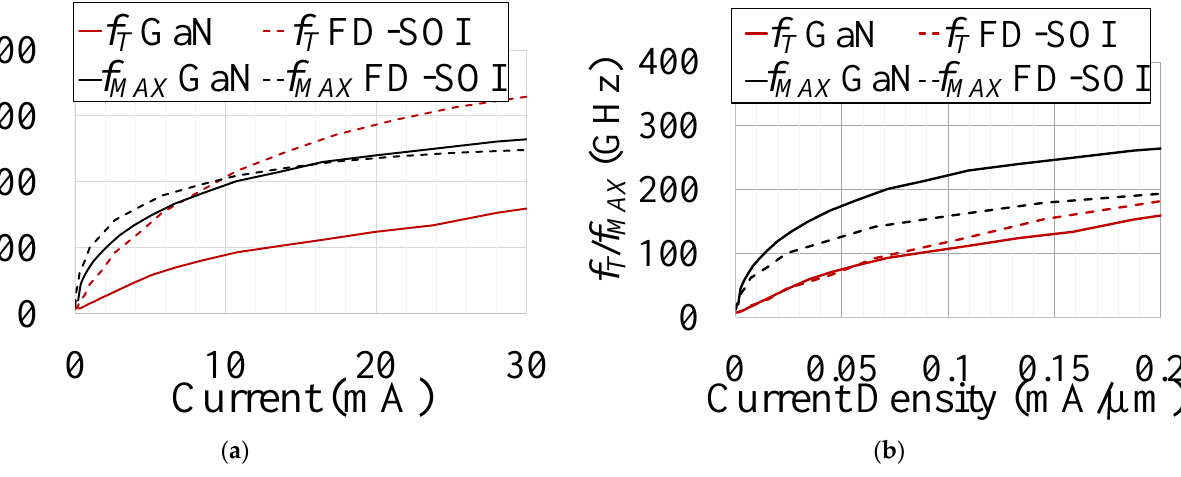
Figure 1. Simulated f T and f MAX of the 40 nm GaN HEMT (4 × 37.5 µm) and 22 nm CMOS FD-SOI (2 × 20 µm) PA power transistors with parasitic elements extracted to the top metal layer and plotted vs. ( a ) bias current (mA); and ( b ) current density (mA/µm).